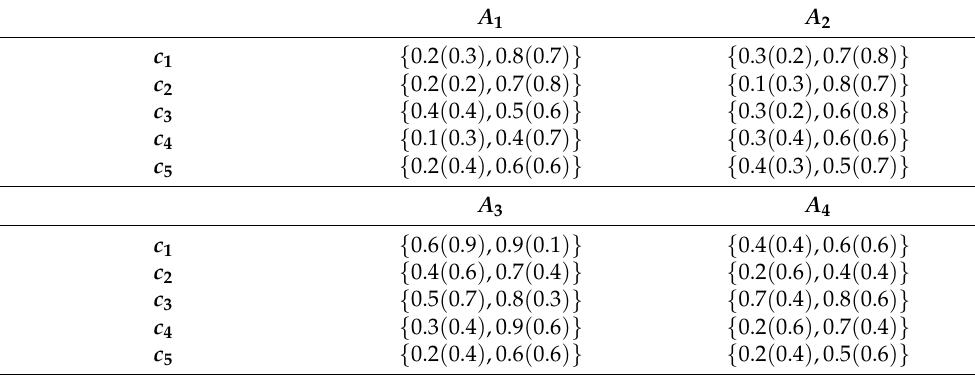
Table 4. Standardized evaluation matrix of Expert 1 ( d 1 ).